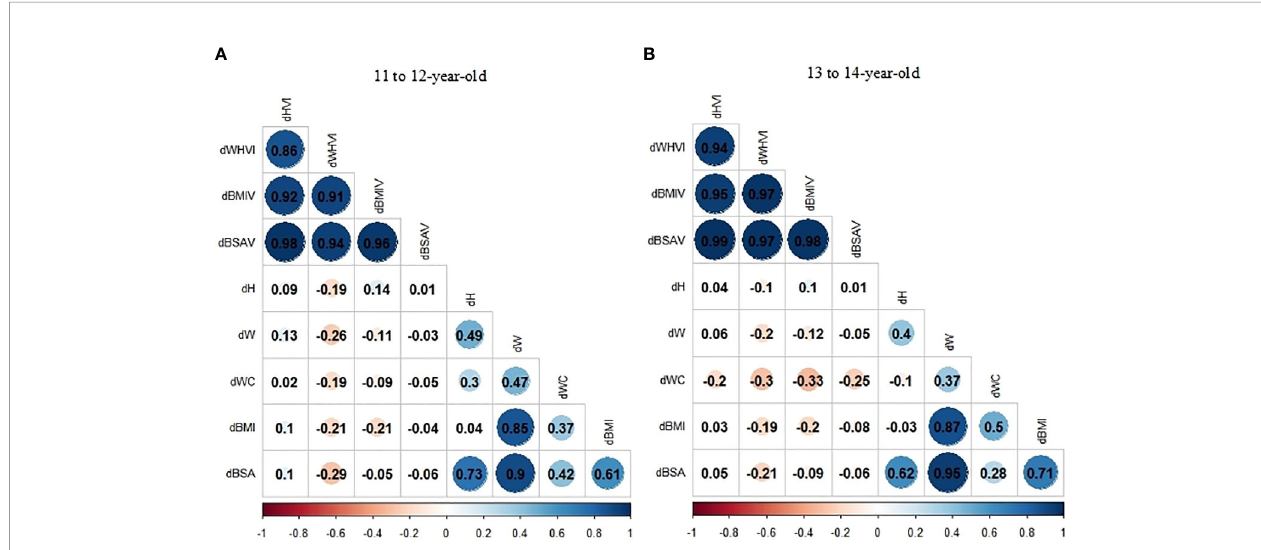
FIGURE 3 | (A, B) Correlation coef fi cients ( r s) of the relationship between thyroid volume indexes (TVI) changes and anthropometric indexes changes strati fi ed by age group by Spearman correlation analyses: (A) 11 to 12-year-old group; (B) 13 to 14-year-old